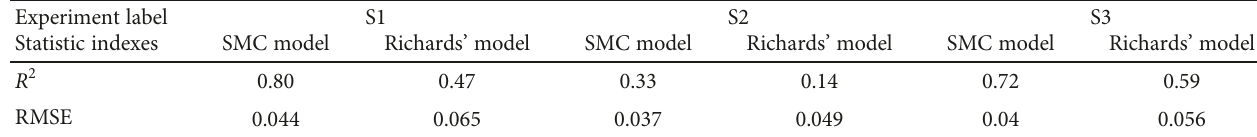
Table 7: Comparison of simulation results by di ff erent models.